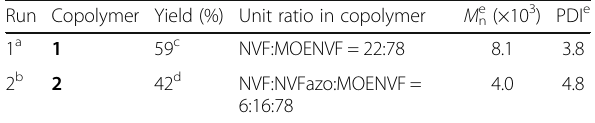
Run Copolymer Yield (%) Unit ratio in copolymer